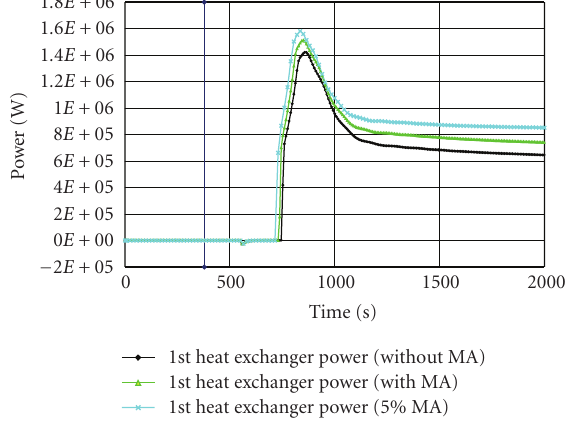
Figure 8: Exchanged power in 1st DHR HX.